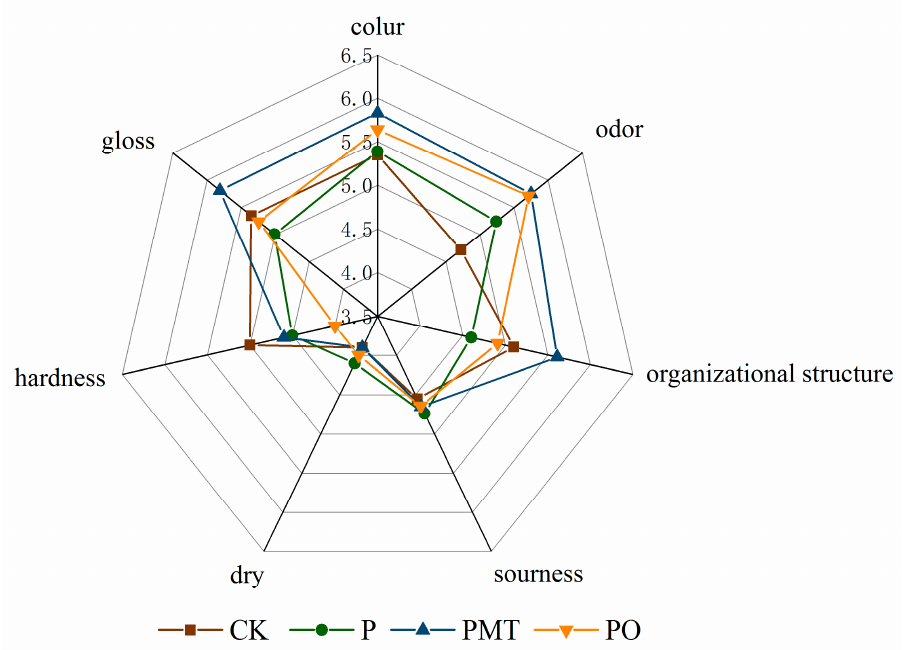
Figure 4. Sensory evaluation of smoked horsemeat sausage. Batch CK: the spontaneously fermented as the control; batch P: inoculated with P. bacillus ; batch PMT: inoculated with P. bacillus and thyme microcapsules; batch PO: inoculated with P. bacillus and essential oil.